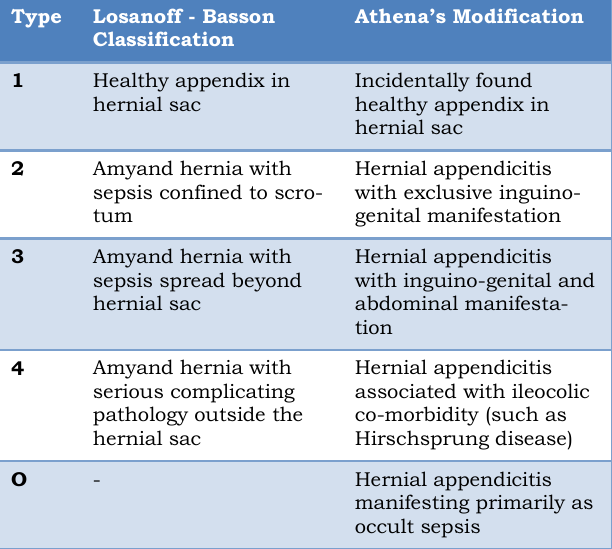
Table 1: Classification of Amyand hernia and Athena’s